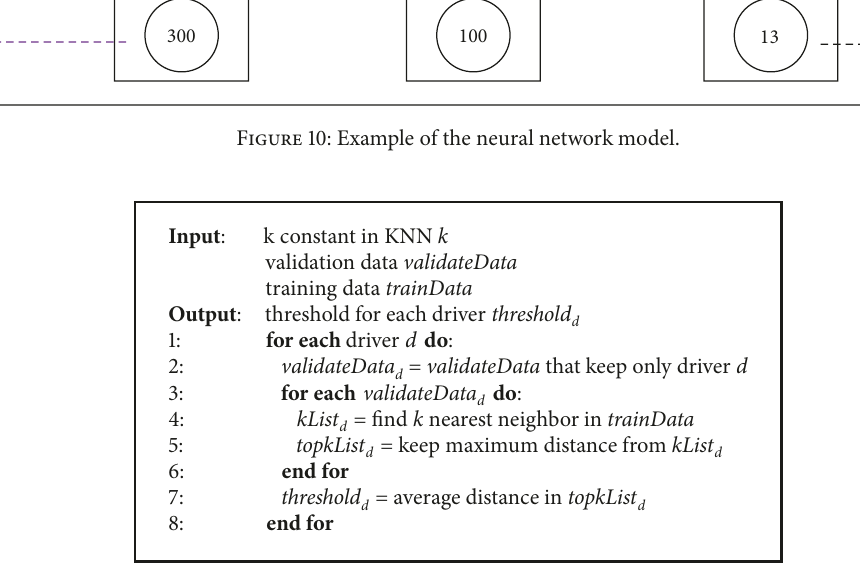
Algorithm 3: Threshold calculation for each driver using the